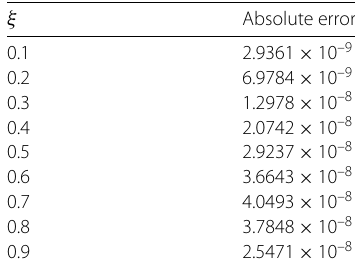
Table 5 Absolute errors of Example